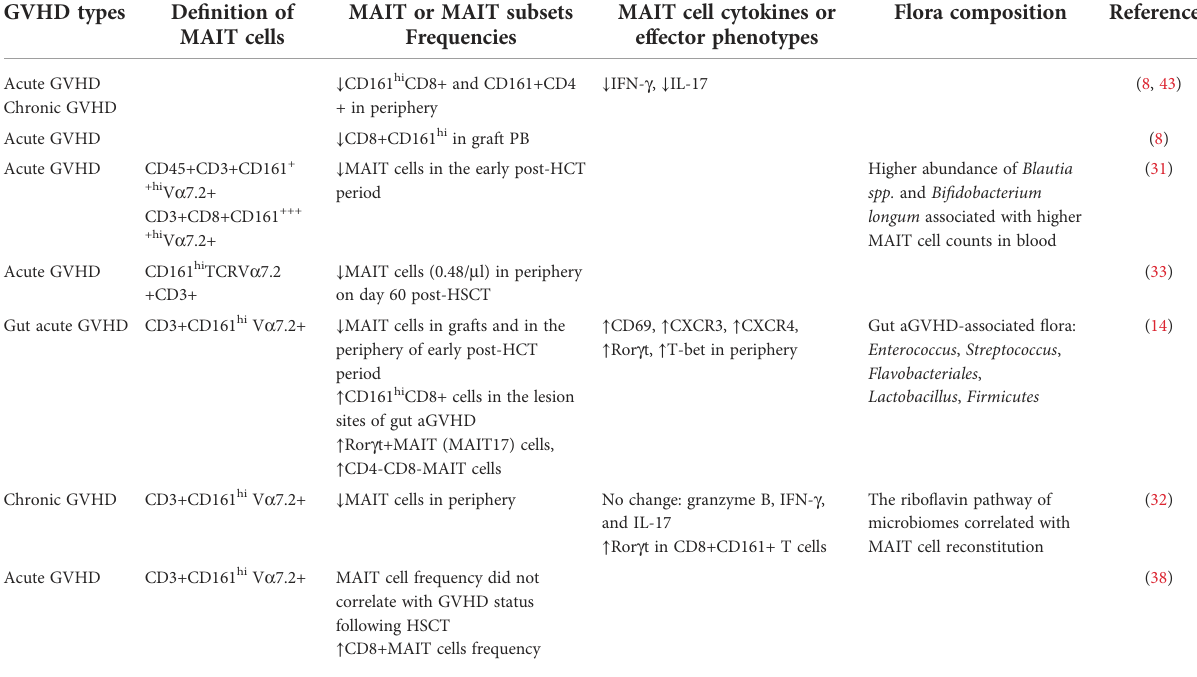
TABLE 1 Summary of research in graft- versus -host